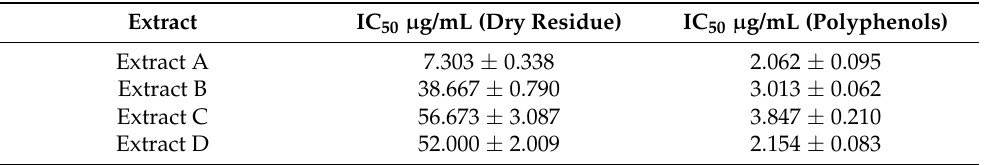
Table 19. Antioxidant activity determined by the DPPH test. Values are reported as µ g/mL in respect to the dry residue and to total polyphenol content.